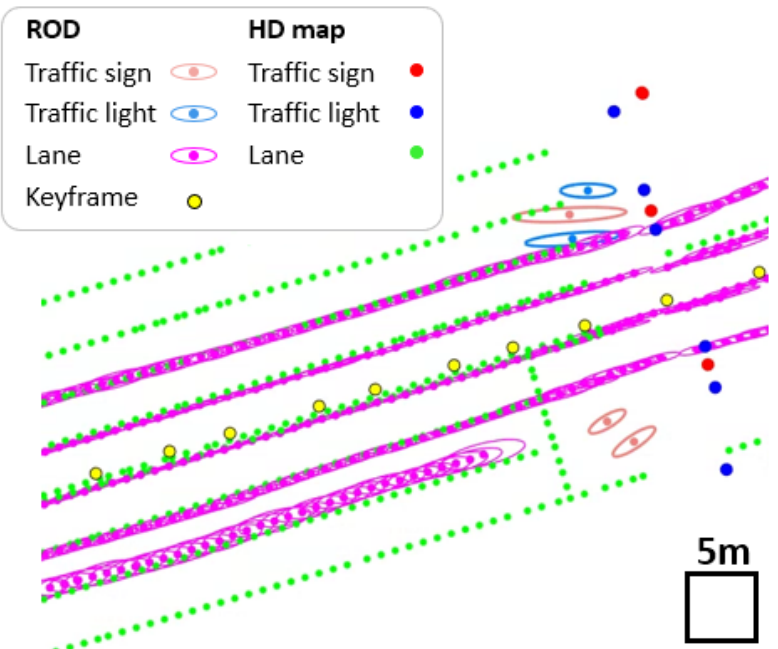
Figure 1. ROD visualization of a single